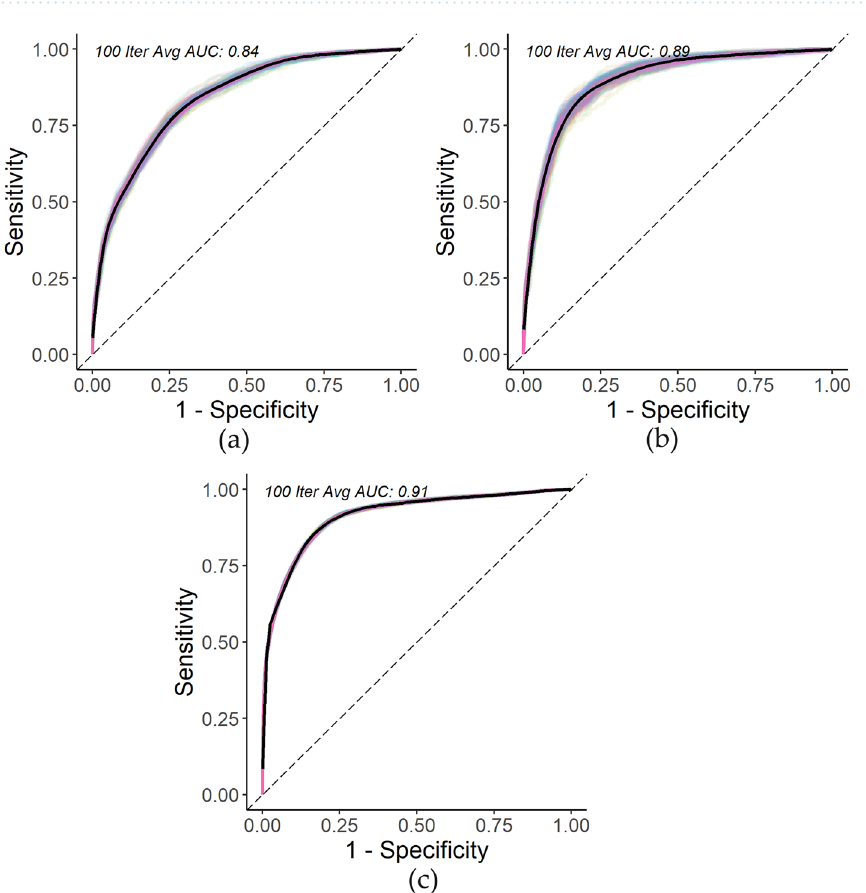
Figure 2. ( a ) Pediatric 30-year Cox survival time-dependent ROC curve over 100 iterations; ( b ) Adolescent 30-year Cox survival time-dependent ROC curve example over 100 iterations; ( c ) Young adult 30-year Cox survival time-dependent ROC curve over 100